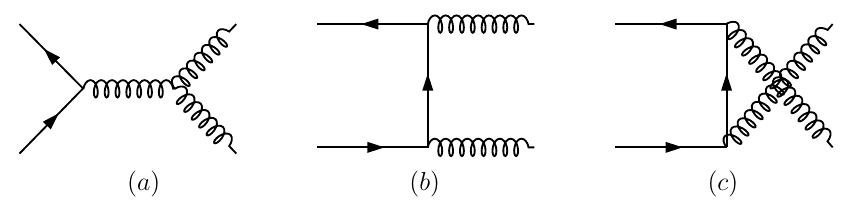
¯ q → A a A b i j P P